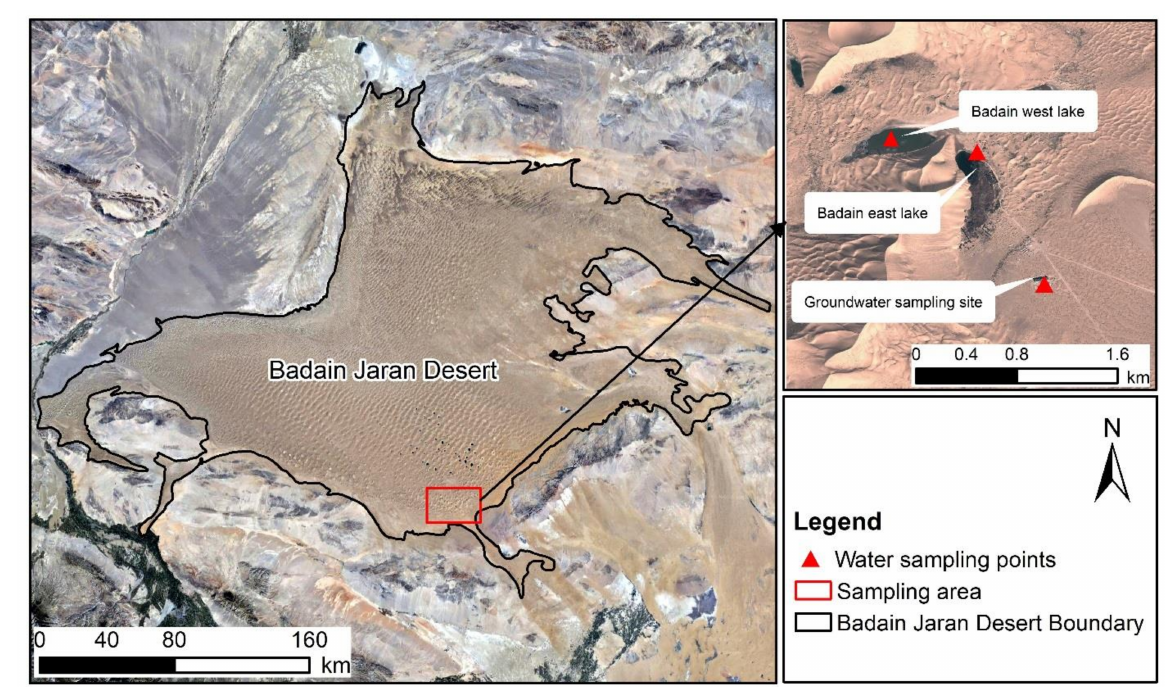
Figure 1. Location of the study area and sampling points.